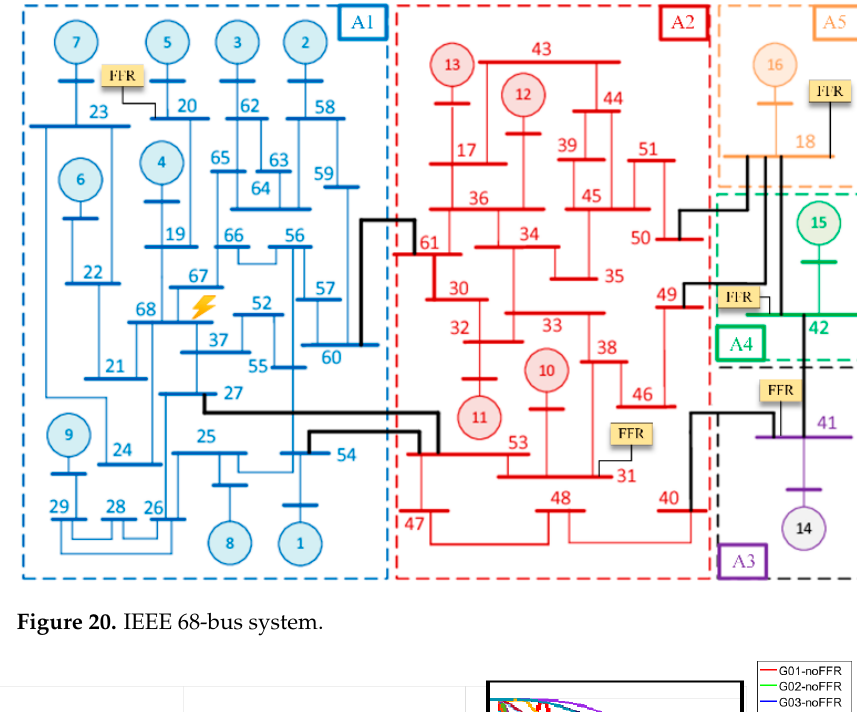
Figure 20. IEEE 68-bus system.